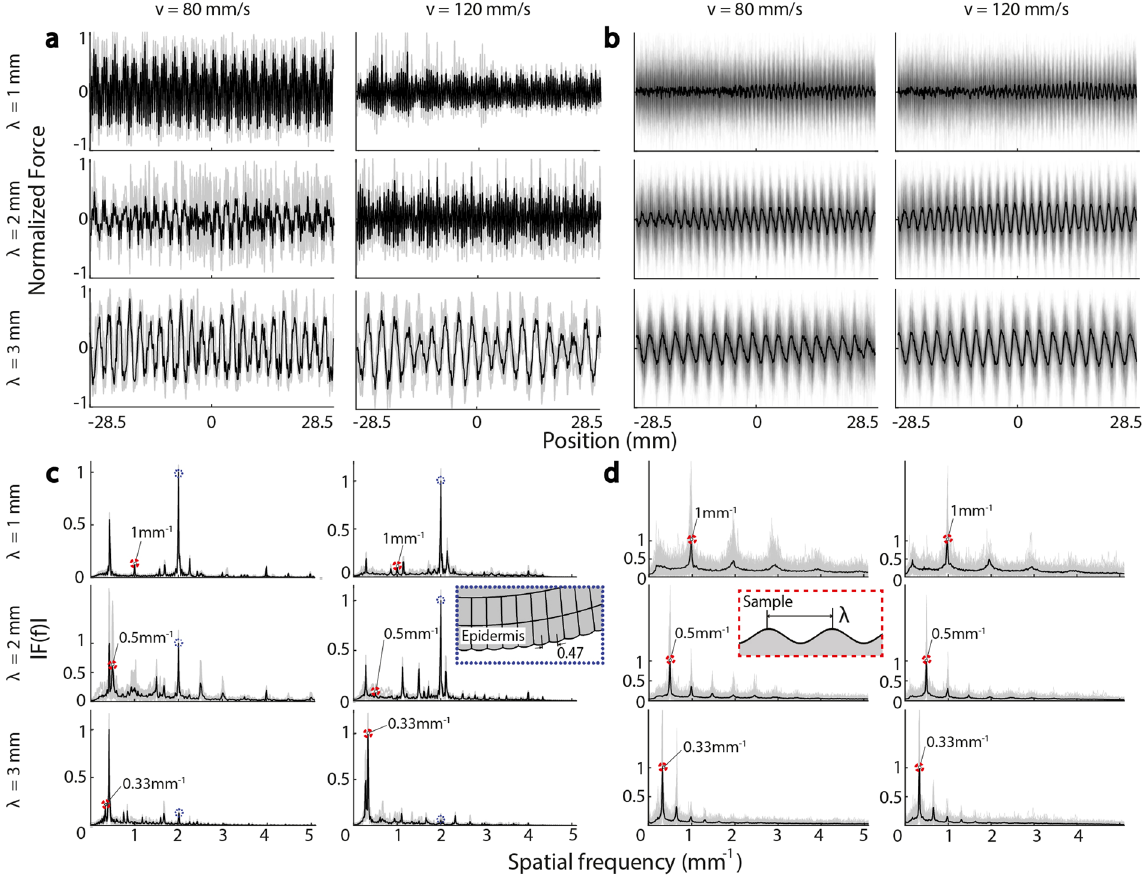
Figure 1. Spatial patterns of ( a ) simulated and ( b ) measured frictional forces (gray lines: individual trials, black lines: ensemble average) at two velocities (80, 120 mm/s) and three surface wavelengths (1, 2, 3 mm). While the force patterns qualitatively reflect the surface period, there was greater variance in the measured force data. The spatial spectra of ( c ) simulated and ( d ) measured forces exhibit prominent peaks, at both harmonic and mixing frequencies. Prominent frequency components associated with the surface period and the epidermal ridge spacing are both